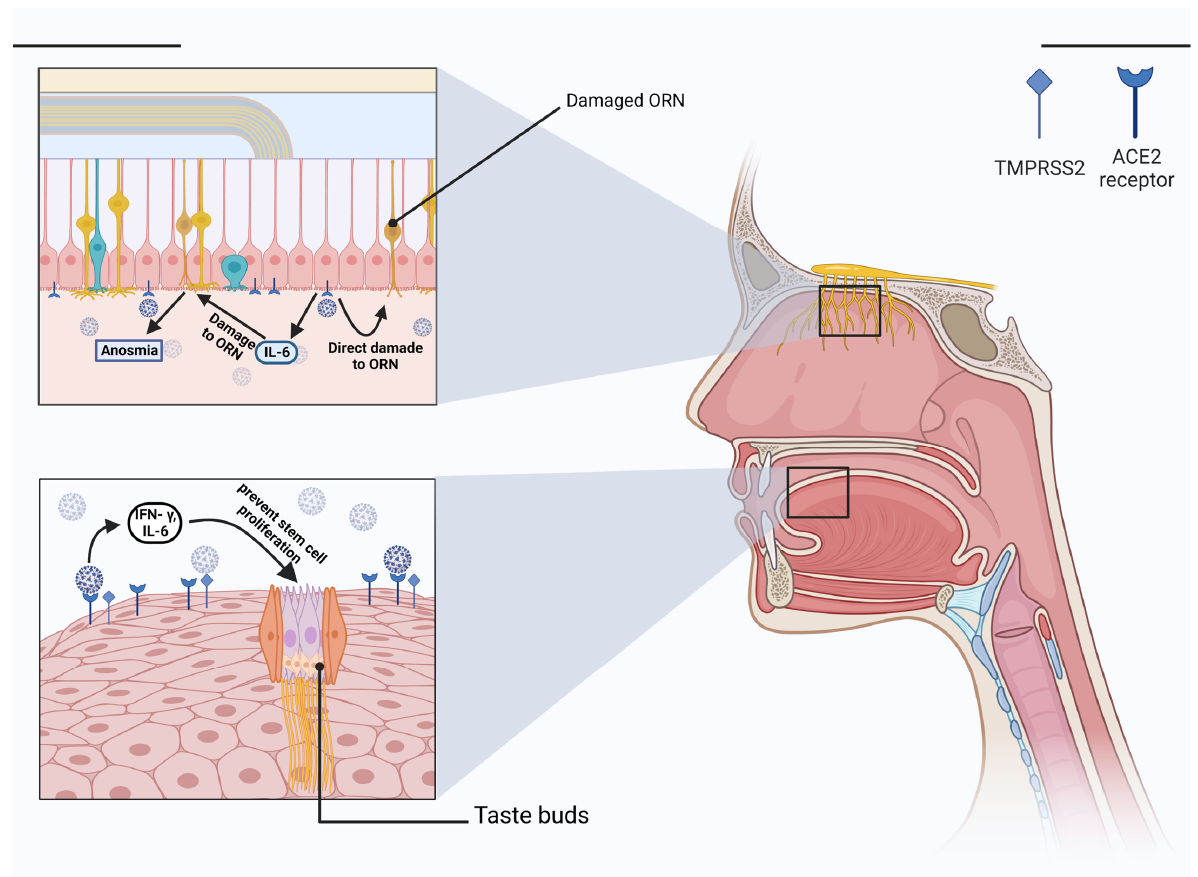
Figure 2. Taste and olfactory dysfunction in COVID-19. IFN- γ and IL-6 are two examples of proinflammatory cytokines that can inhibit stem cells growth and reduce the lifespan of taste bud cells. Another sense that plays a role besides taste is smell. In contrast to ORN and olfactory bulb cells, sustentacle cells express high levels of ACE-2 and TMPRSS2. Loss of cilia on ORN due to infection of the sustentacular cells can interfere with the transmission of the odorous stimulus. Anosmia caused by COVID-19 was also linked to IL-6, proving the importance of this cytokine in the disease’s etiology. (Created with